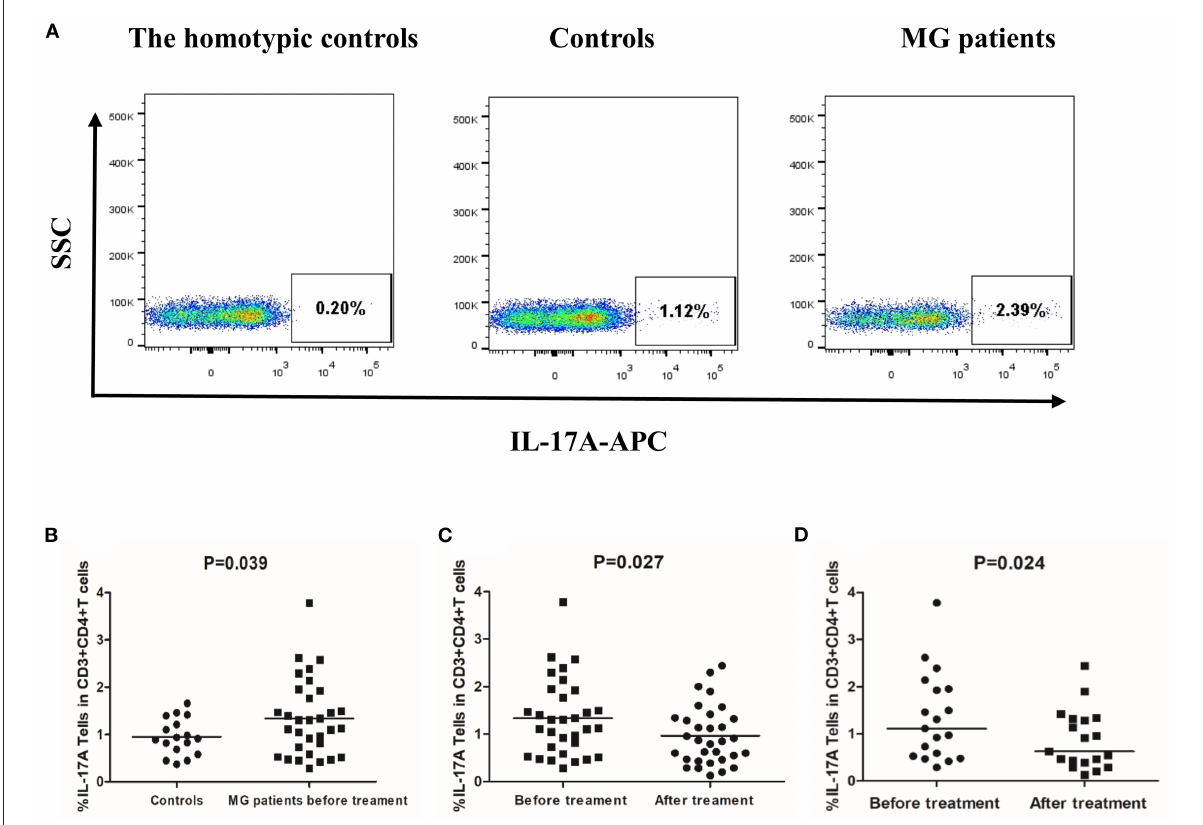
FIGURE7 Frequency of Th17 cells (CD3 + CD4 + IL-17A + T cells) in PBMCs of controls and MG patients. (A) Gating on CD3 + CD4 + T cells and intracellular cytokine analysis for IL-17A on PBMCs of controls and MG patients after cell culture. (B) Th17 cell frequency in controls and MG patients before treatment. (C) Th17 cell frequency in MG patients before and after treatment. (D) Th17 frequency in responsive patients before and after treatment. The horizontal bars indicate the mean. We compare MG patients and controls using unpaired t –test. We compared before and after treatment using paired t